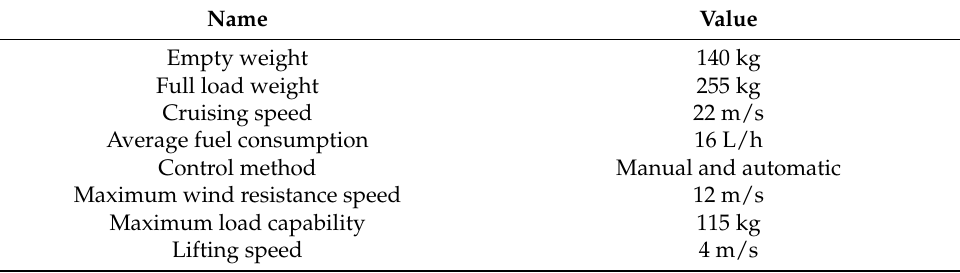
Figure 1. The drone used in LY100 fire extinguishing system. Table 1. The main performance parameters of the drone used in LY100